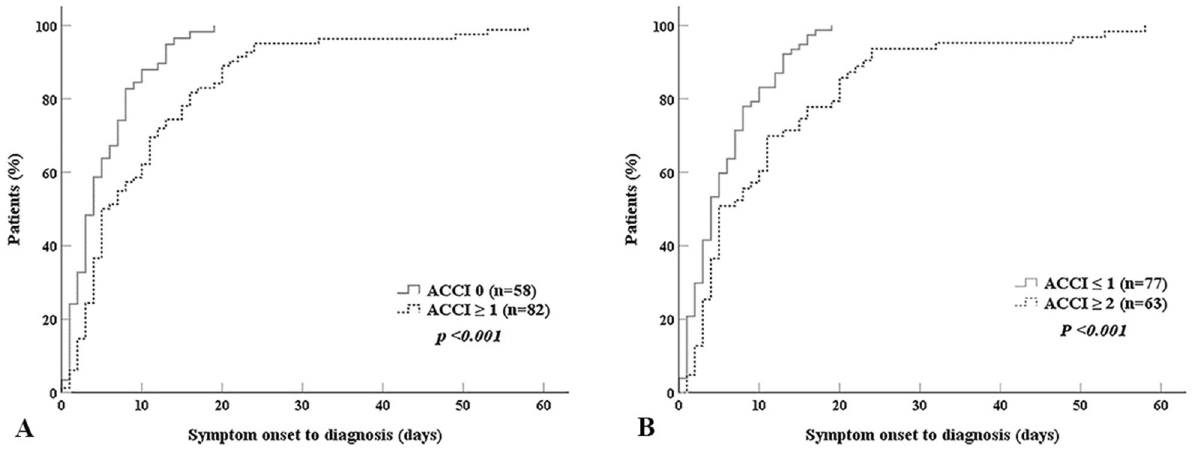
Figure 2. Cumulative incidence curves for diagnosis of Guillain–Barre syndrome after symptom onset are compared between the patients with ( A ) age-adjusted Charlson Comorbidity Index (ACCI) of 0 and ACCI ≥ 1 and ( B ) ACCI ≤ 1 and ACCI ≥ 2.